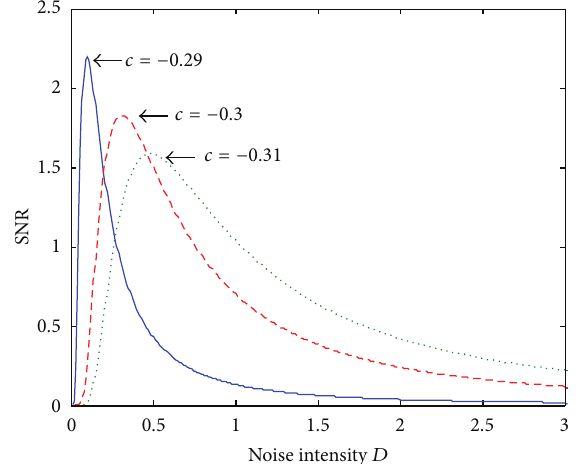
Figure 6: The variation curve of the output signal amplitude with the addition of noise 𝐷